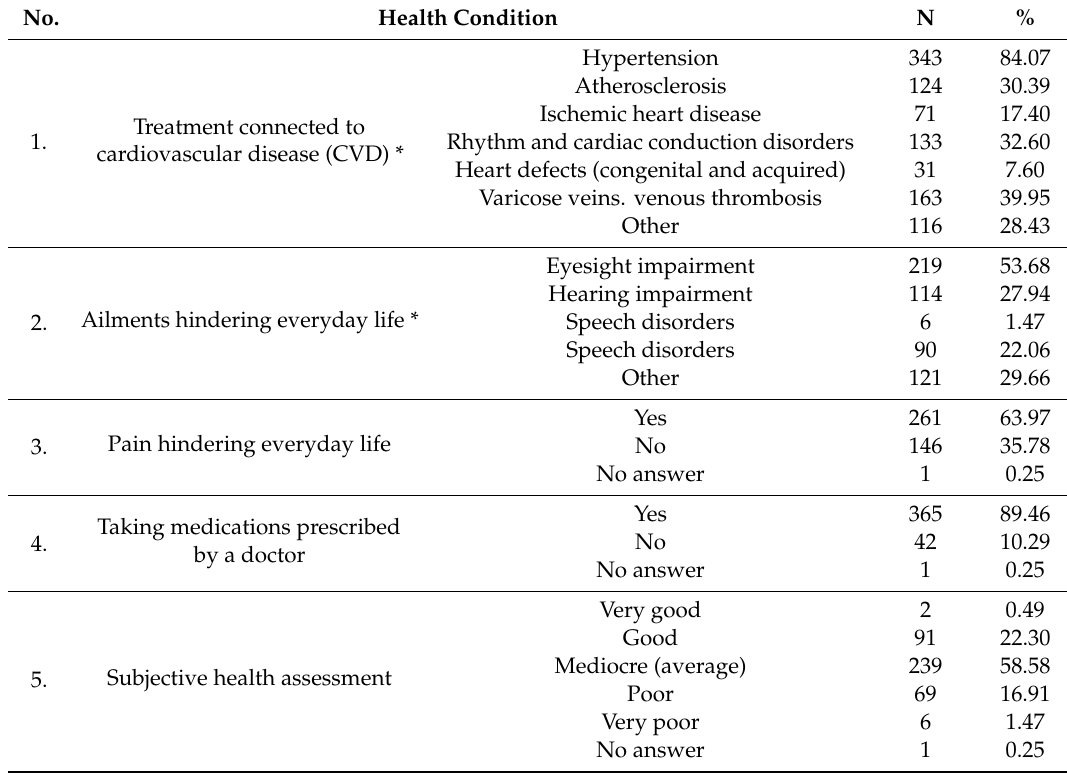
Table 2. Health condition of the